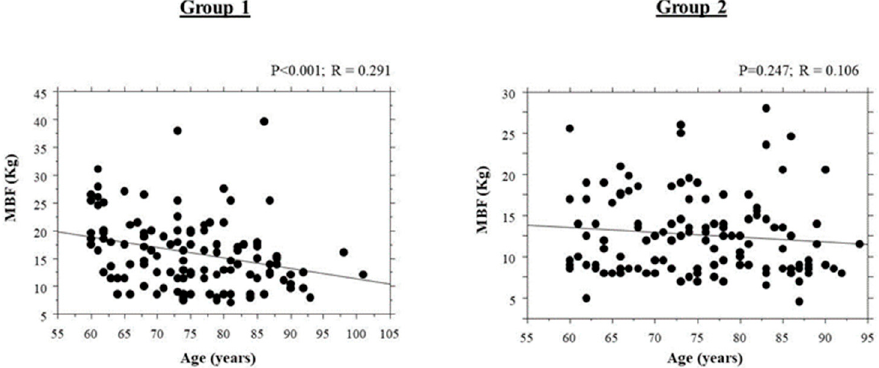
Figure 4. Correlations of maximal bite force with the age of the subjects. MBF = Maximal Bite Force.